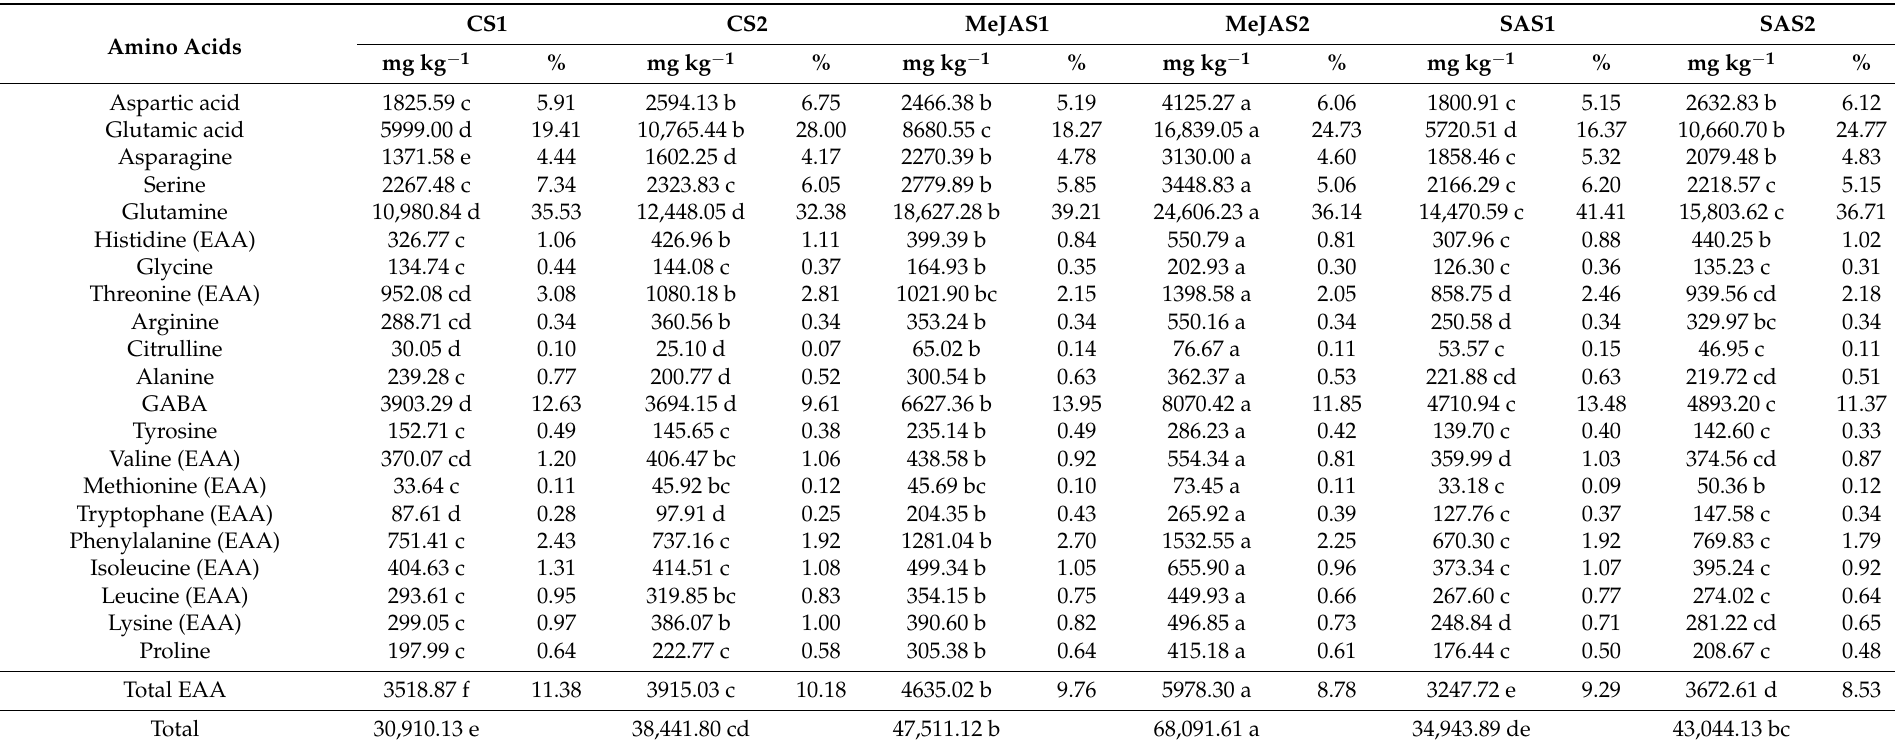
Table 2. Free amino acids content in the preharvest MeJA and SA treated and control fruit of ‘Kumato’ tomato cultivar at two maturity